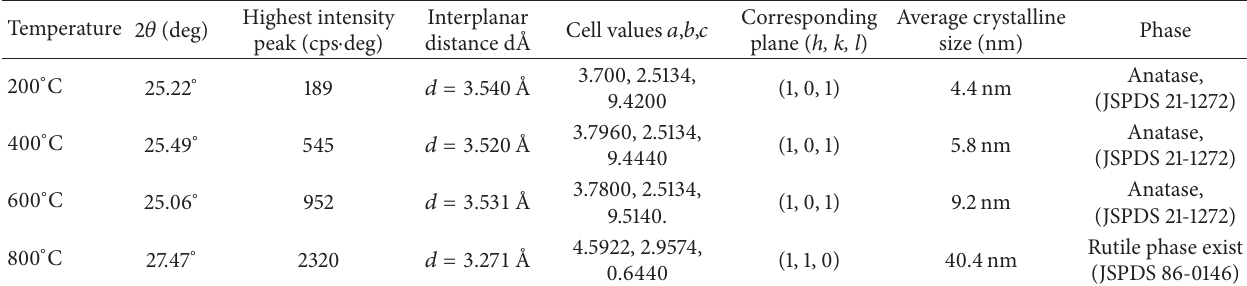
for different temperatures. 2